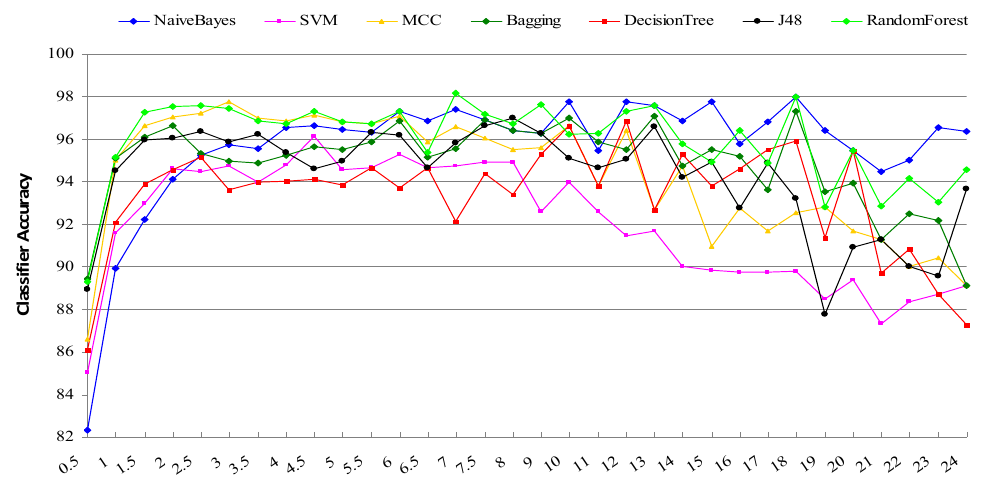
Figure 6. Classification accuracies of NaiveBayes, SVM, MCC, Bagging, Decision Tree, J48, and RandomForest for different window sizes using the FNSW segmentation